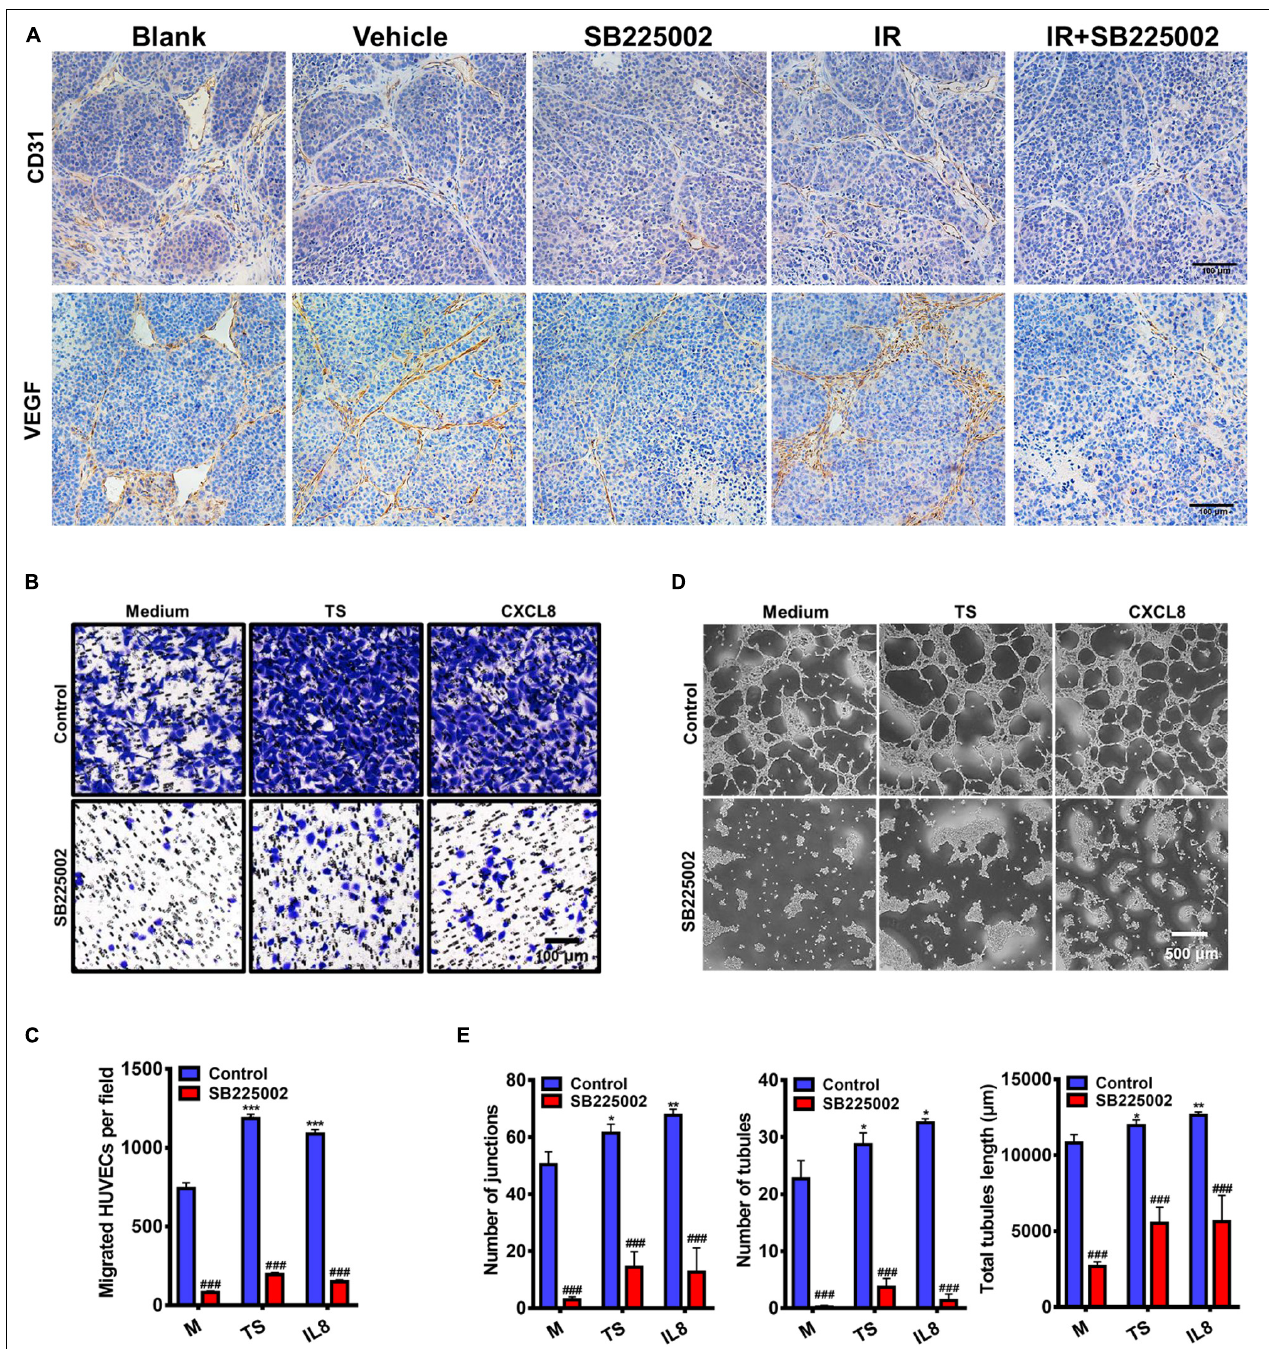
FIGURE 6 | Regulation of tumor angiogenesis by CXCR2 inhibitor. (A) Paraffin-embedded C666-1 tumor sections after SB225002 combined radiotherapy treatment were examined by immunohistochemical analysis with anti-CD31 and anti-VEGF antibody. Representative tumor vasculature from five groups was shown. (B) Representative photographs of HUVECs migration in vitro . HUVECs were seeded into the upper chamber of a transwell system, and tumor culture medium supernatant (TS) of nasopharyngeal carcinoma cell C666-1, human recombinant protein CXCL8 or SB225002 (0.5 µ M), was added to the bottom chamber. Scale bar = 100 µ m. (C) Statistical analysis of the number of migrated HUVECs. Data were assessed by ImageJ, showing as Mean ± SD ( n = 3; *** p < 0.001; ### p < 0.001. * represent p value between tumor supernatant or CXCL8 group and serum free medium group, # represent p value between groups with or without SB225002. (D) Representative photographs of HUVEC tubule formation in vitro grown on the Matrigel after 3-4 h in the presence of tumor supernatant, human recombinant protein CXCL8 (50ng/ml) or SB225002(0.5 µ M), compared to free serum medium. Scale bar = 500 µ m. (E) Statistical analysis of junctions, tubules and total tubule length formed by HUVECs. Data were assessed by ImageJ showing as Mean ± SD ( n = 3; * p < 0.05; ** p < 0.01; ### p < 0.001. * represent p value between tumor supernatant or CXCL8 group and serum free medium group, # represent p value between groups with or without SB225002.